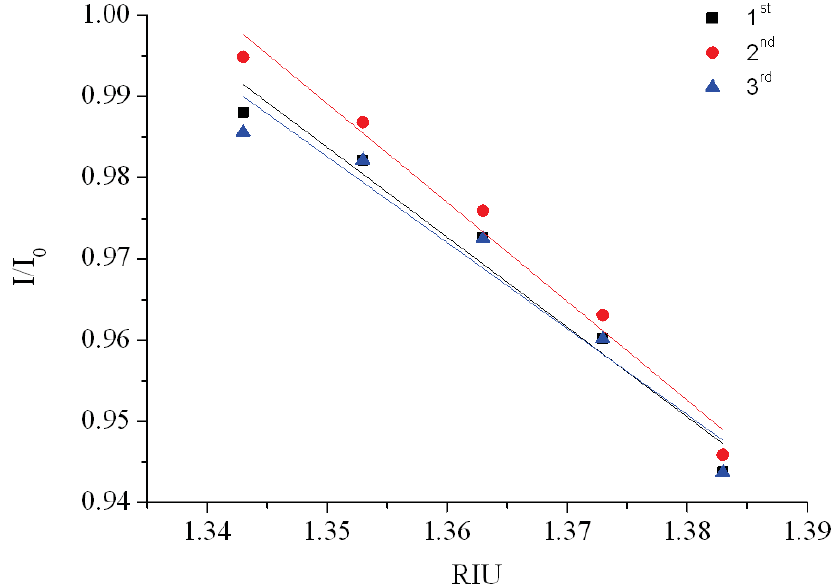
Figure 22. Plot of the ATR fiber sensor response versus the refractive index of the sucrose solution.